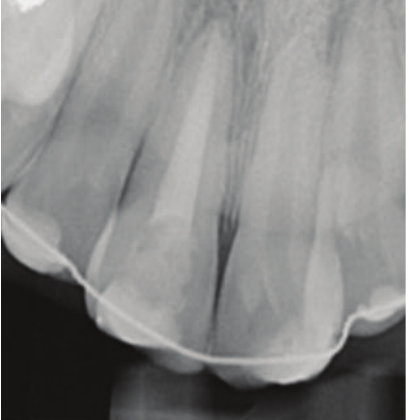
Figure 8: Periapical radiograph after replantation of avulsed